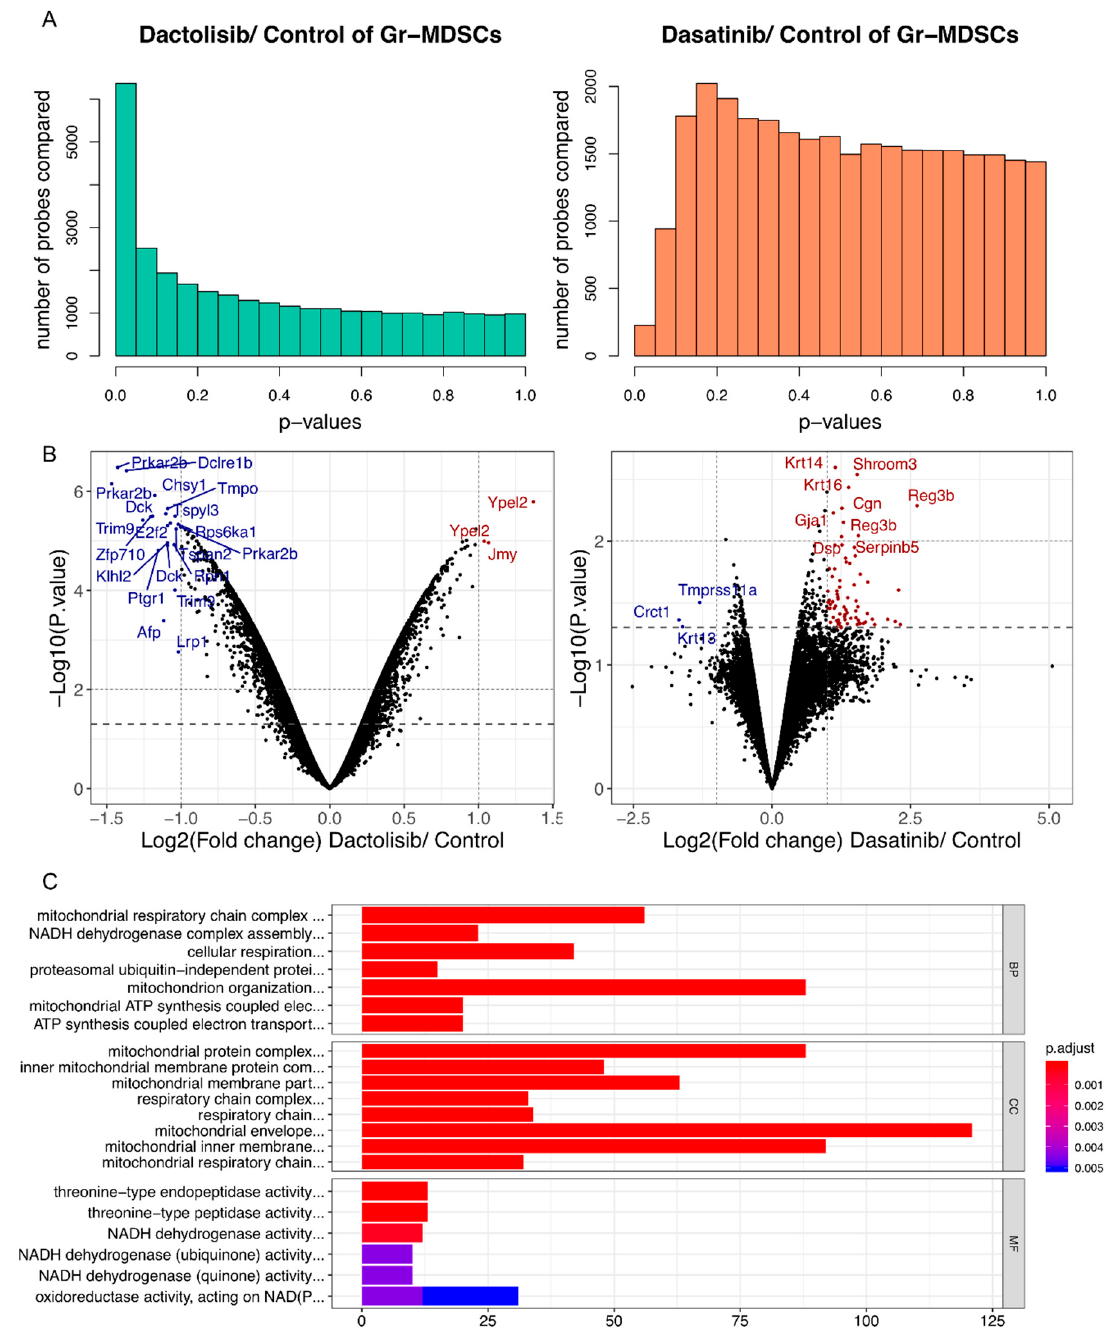
Figure 5. Dactolisib, but not Dasatinib, downregulated mitochondrial respiration genes in Gr-MDSCs based on microarray analysis. ( A ) p value distributions for di ff erentially expressed probes between Dactolisib and DMSO control, or between Dasatinib and DMSO control based on unpaired t -test. ( B ) Volcano plots showing di ff erentially expressed genes by Dactolisib or Dasatinib treatment on Gr-MDSCs. Some of the most significantly altered genes are labeled. Blue / Red: downregulated / upregulated genes by inhibitor treatment. ( C ) GO term over-representation analysis of downregulated genes by Dactolisib treatment, highlighting the enrichment of genes involved in mitochondrial respiration activity. BP: biological process; CC: cellular component; MF: molecular